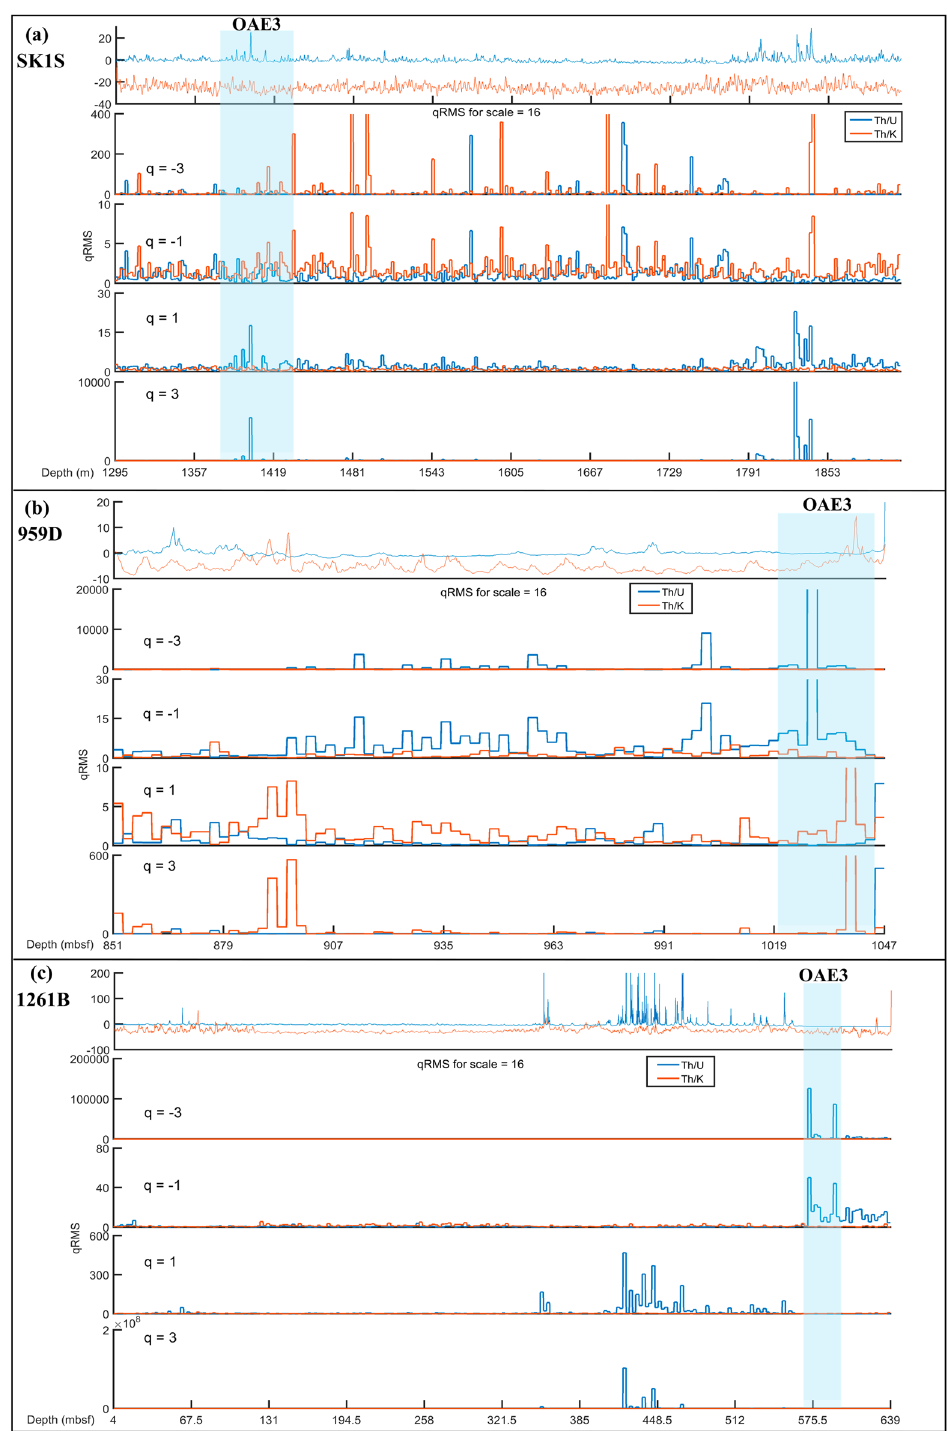
Figure 11. The q -order RMS of the thorium–uranium and thorium–potassium distribution in the studied OAE3